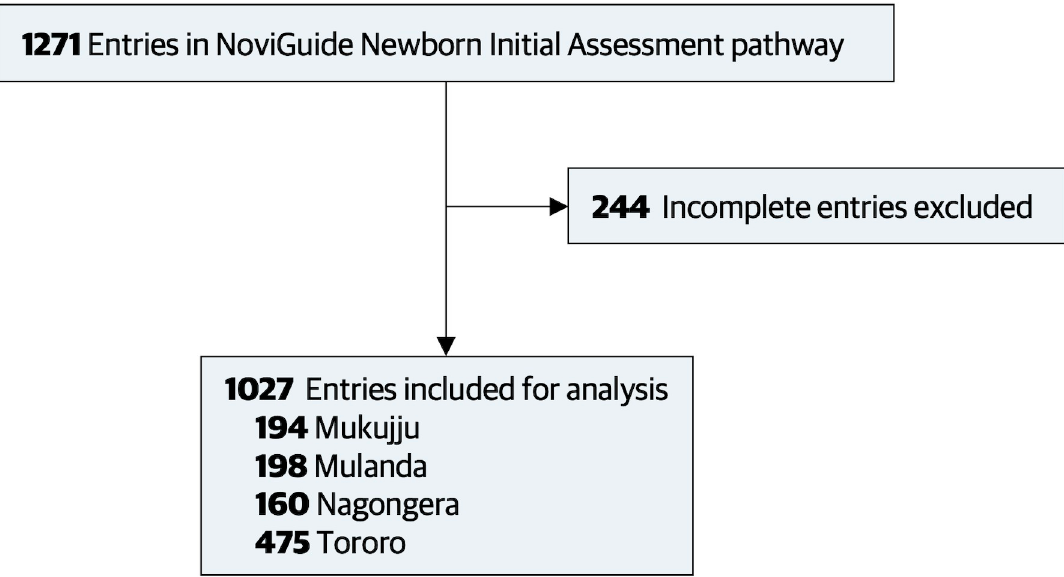
Fig 1. Study flow diagram for NoviGuide usage